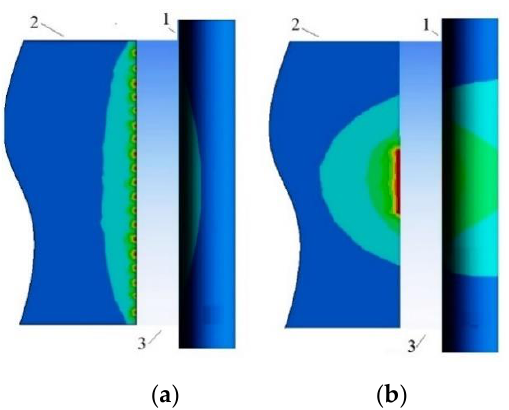
Figure 1. Temperature fields during WEDM in the cases of ( a ) uniform distribution of discharges over the treated surface; and ( b ) localization of discharges in a relatively small area. Symbols 1, 2 and 3 denote zones of the electrode-tool, electrode-workpiece and interelectrode gap with the dielectric fluid, respectively.